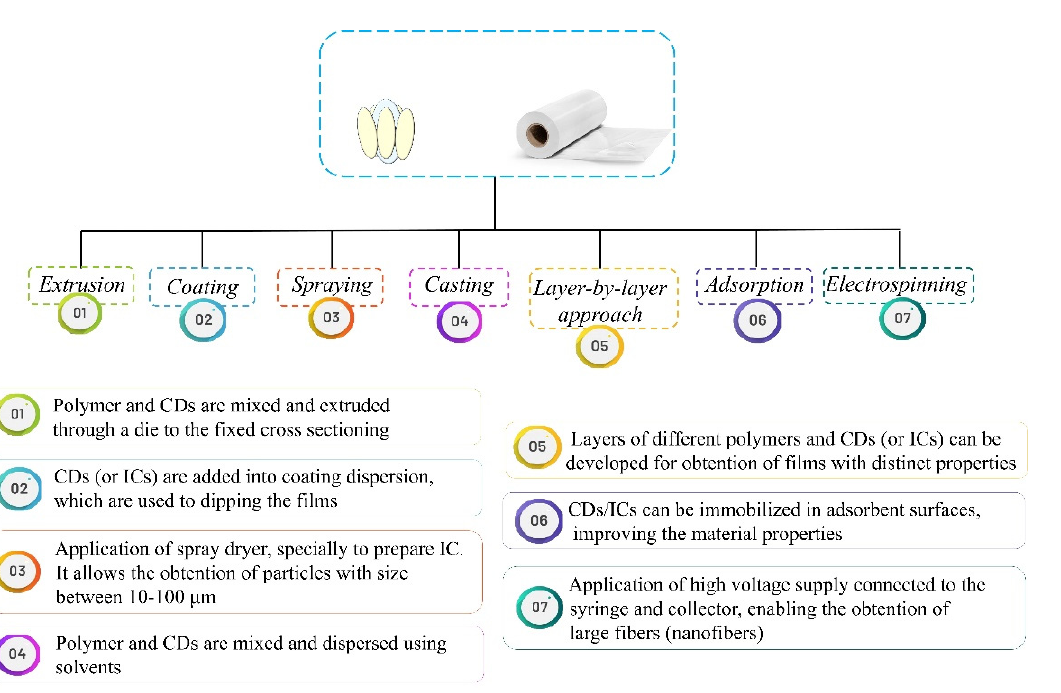
Figure 2. Different methods aiming the obtainment of films containing cyclodextrins (CDs) or their inclusion complexes (ICs).